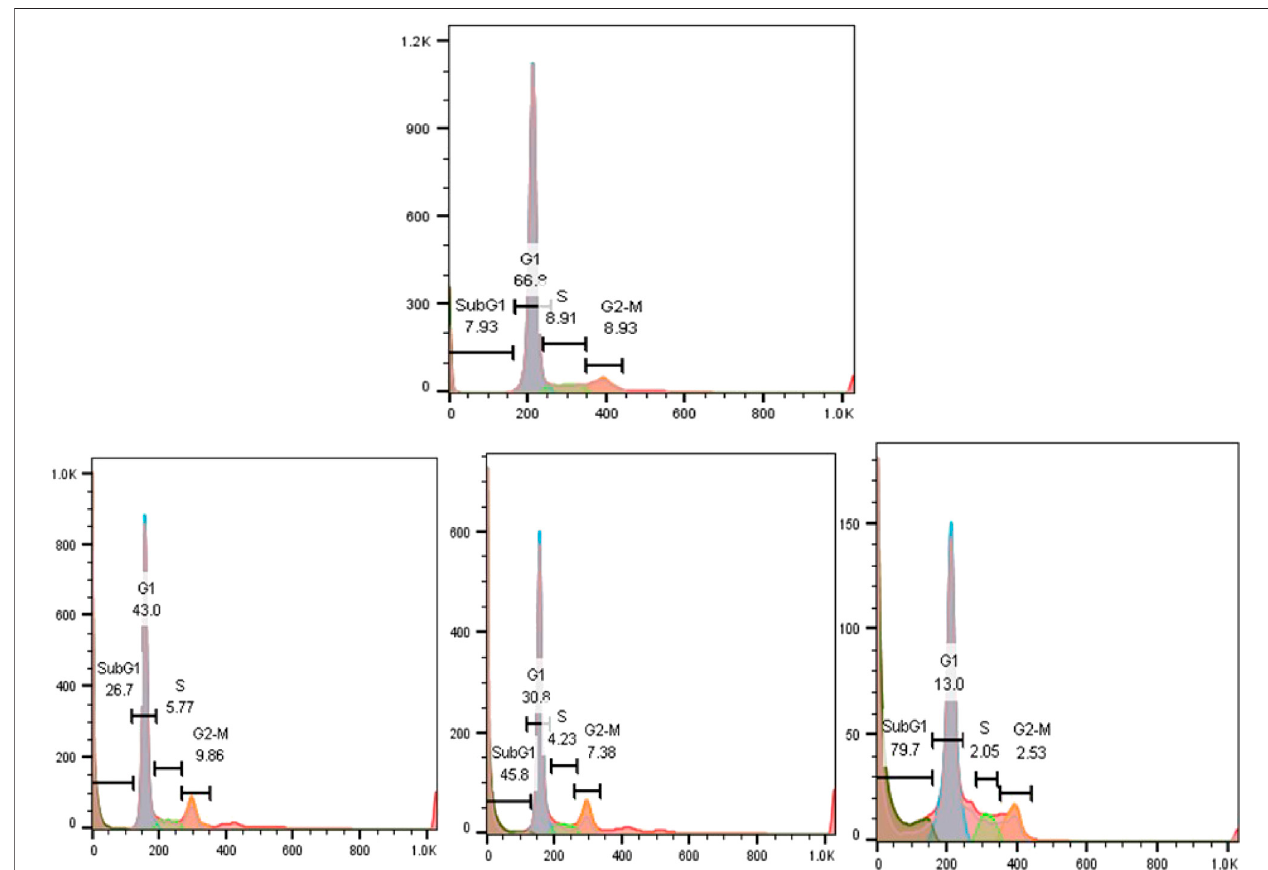
FIGURE 5 | Cell cycle analysis in MCF7 cells treated with different concentrations of SEO-SCF-NPs.